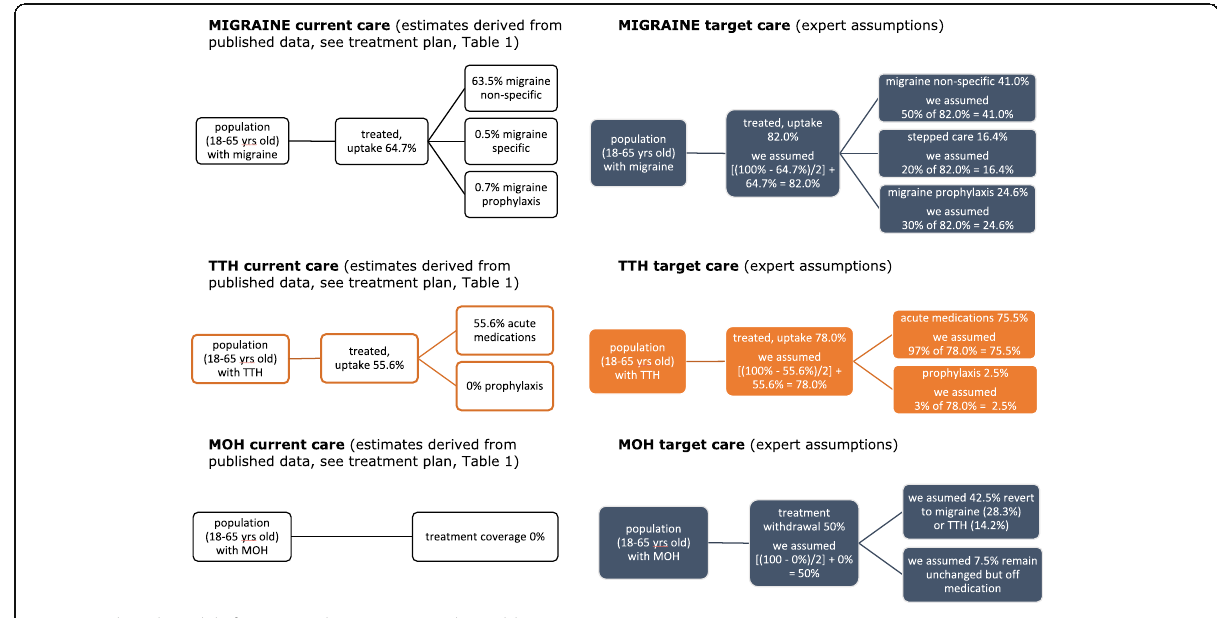
Fig. 3 Analytical models for Russia (data are reported in Table